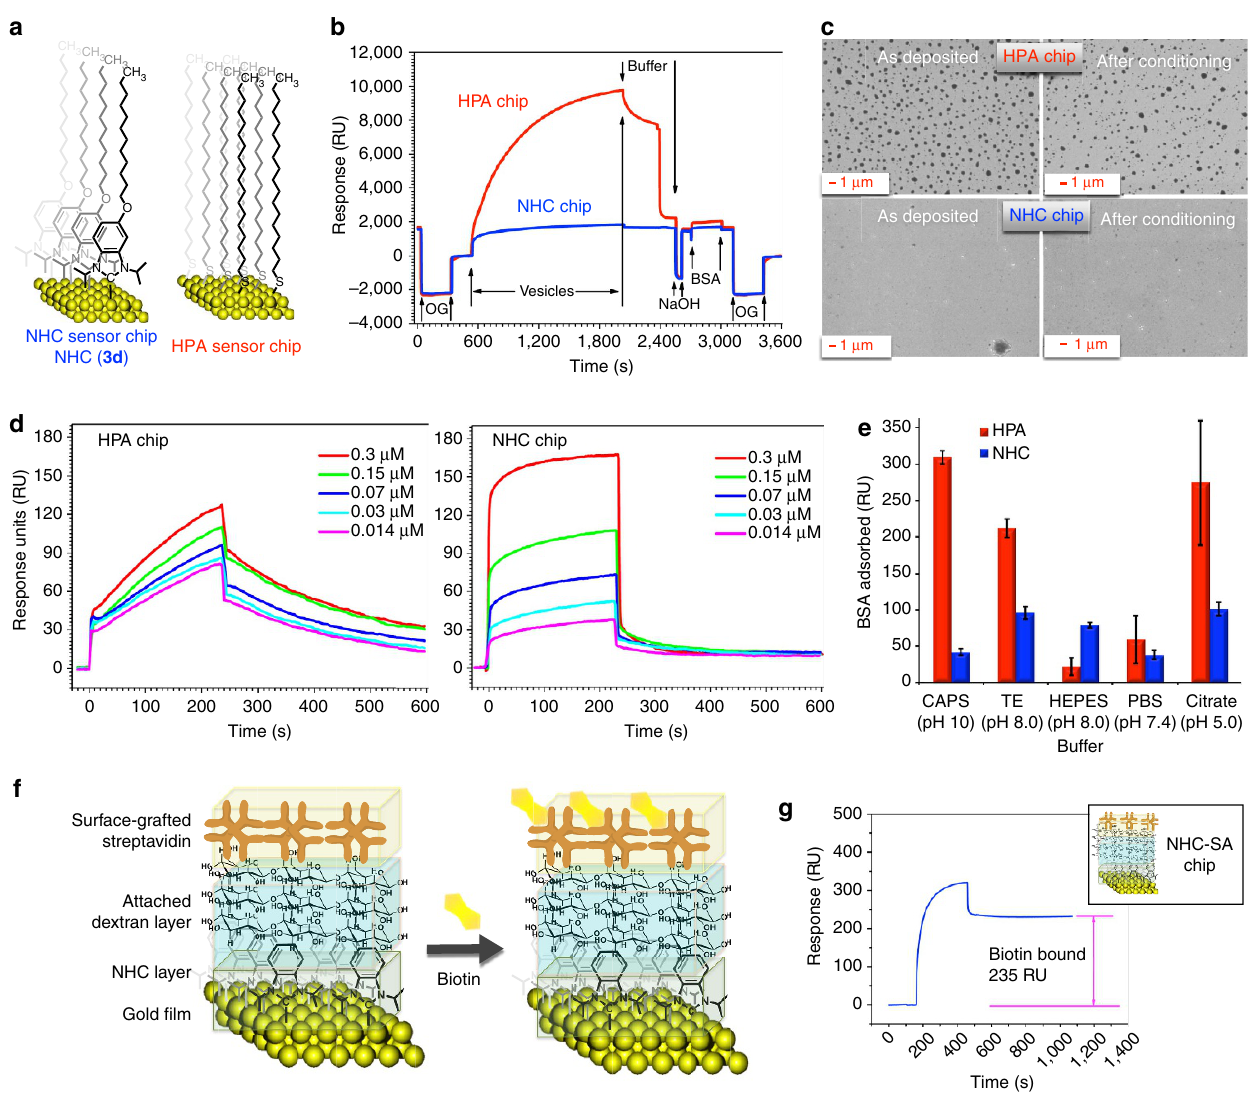
Figure 4 | SPR-based biosensing with NHC chips. ( a ) Structures of NHC and HPA coatings. ( b ) Planar supported hybrid bilayer formation on NHC and HPA chips as monitored by SPR. ( c ) Analysis of chips from b by scanning electron microscopy, indicating vesicle presence on HPA chips. ( d ) Quantitative melittin sensing on the HPA (left) and NHC (right) chips. ( e ) Run-to-run variability in BSA adsorption on both chips as a function of buffer and pH. Average of four to eight runs in each case with standard deviation shown as a black bar. ( f ) Schematic illustration of biotin sensing on NHC-based dextran-linked version of streptavidin (NHC-SA) chip surface. ( g ) Response of biotin as observed on the NHC-SA chip